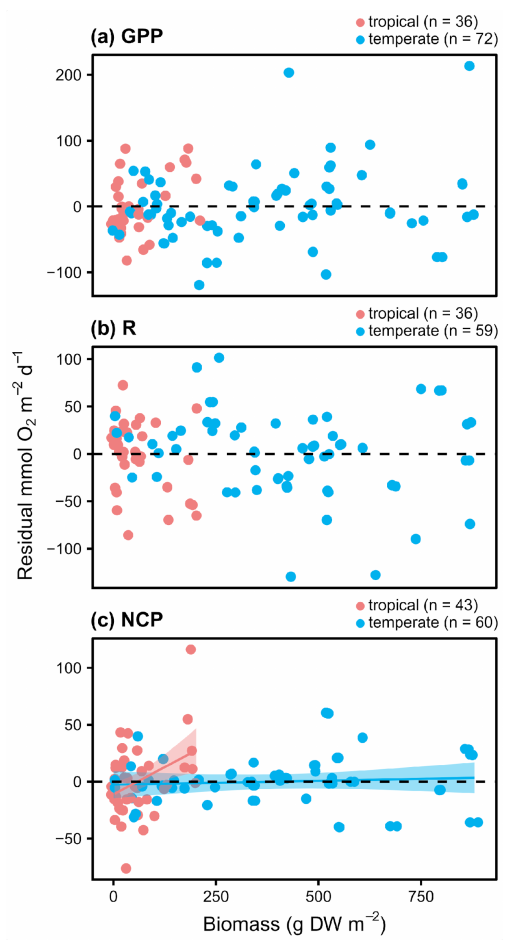
Figure 5. Conditioned residuals of the daily rates for seagrass O 2 fluxes (mmolm − 2 d − 1 ) from a seasonal model as a function of aboveground biomass measured in the field during metabolism mea- surements. Studies performed in temperate versus tropical ecosys- tems are illustrated by color (blue is temperate, red is tropical). Sig- nificance is denoted by a fit line and 95%